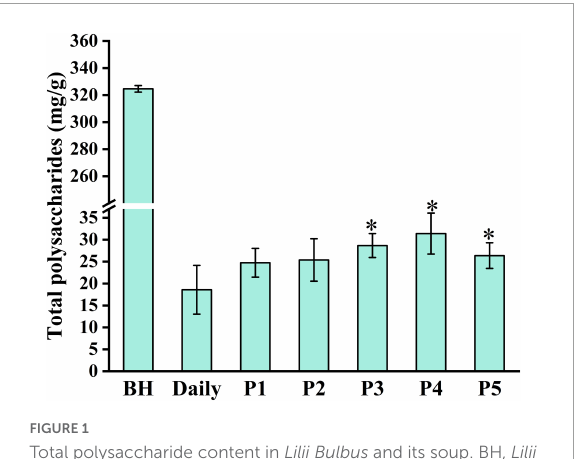
FIGURE1 Total polysaccharide content in Lilii Bulbus and its soup. BH, Lilii Bulbus ; Daily, Daily process; P1, Process 1; P2, Process 2; P3, Process 3; P4, Process 4; P5, Process 5. Significant differences between Daily and other processes (Student’s t -test): ∗ P < 0.05.